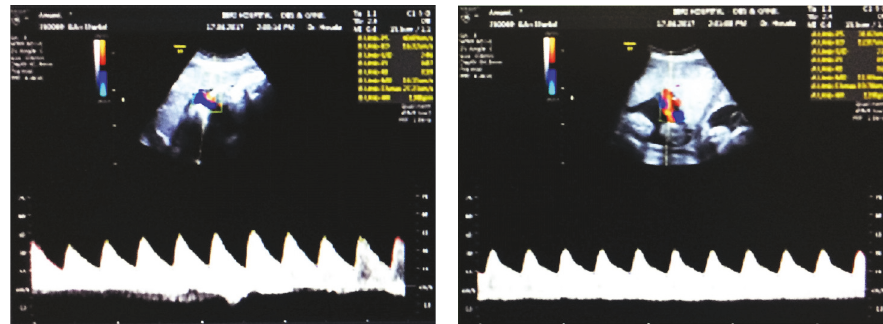
Figure 3: Umbilical artery Doppler for both fetuses at 33 weeks of